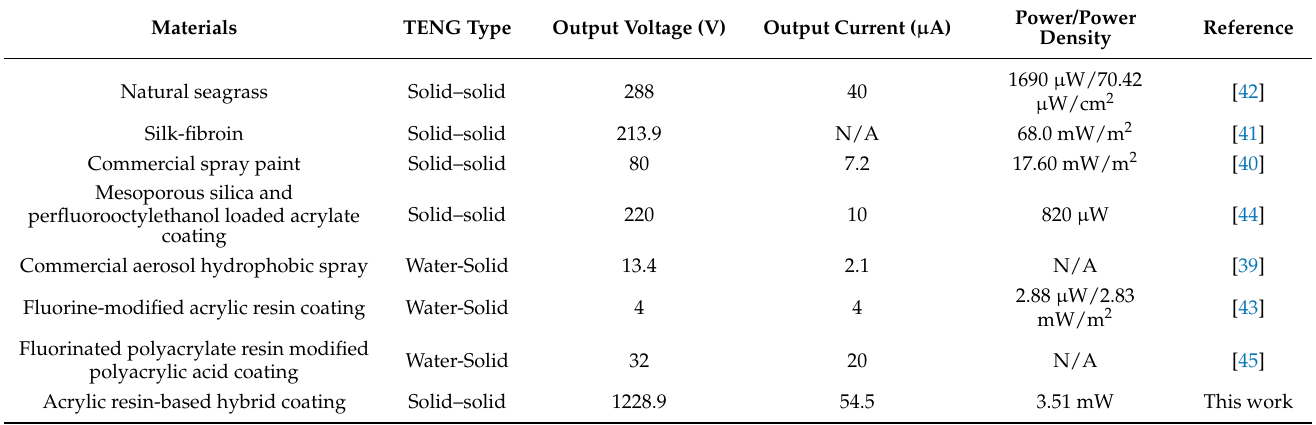
Figure 5. The output performance of the TENG based on hybrid compositions. ( a ) short circuit current, ( b ) open circuit voltage, ( c ) transferred charge, ( d ) current and output power under the different load resistance. Comparison by bar plot of the current and voltage ( e ) and transferred charge and output power ( f ) of the TENGs based on DFHMA, BA and 1:1 mixture of DFHMA and BA. Table 1. Comparison of output performances of TENGs based on spray-coating